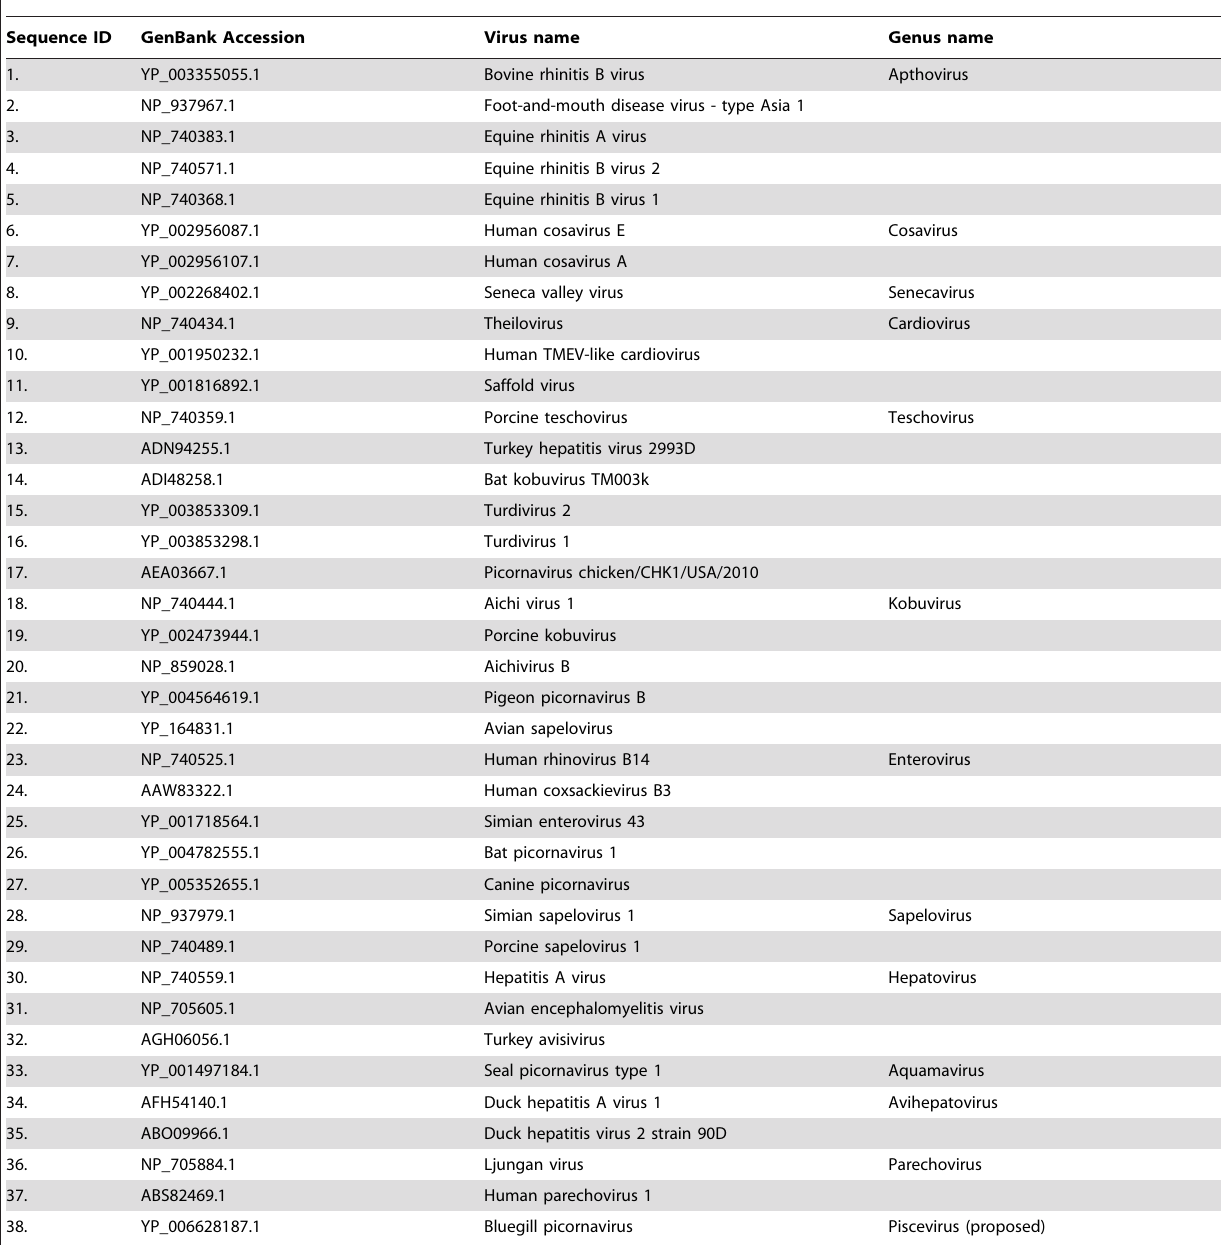
Table 2. Related members of the Picornaviridae family used for phylogenetic analysis.